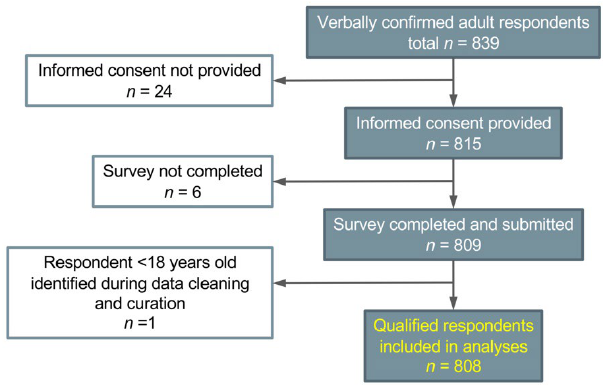
Figure 1. Flow diagram of study participants.